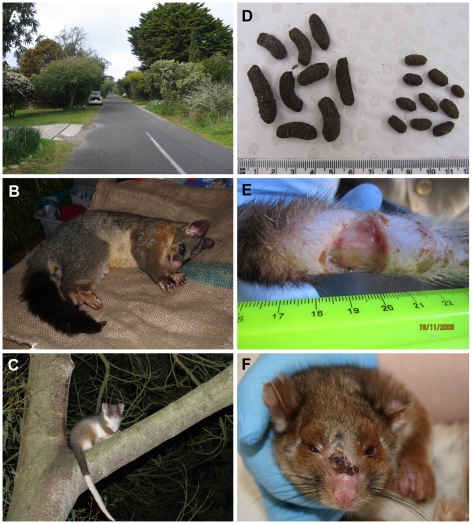
Photographs of Point Lonsdale, common brushtail possums and common ringtail possums.A. Point Lonsdale streetscape showing typical possum habitat. B. Common brushtail possum. C. Common ringtail possum. D. Brushtail possum faeces (left) and ringtail possum faeces (right). E. Ringtail possum tail lesion. F. Ringtail possum nose lesion.